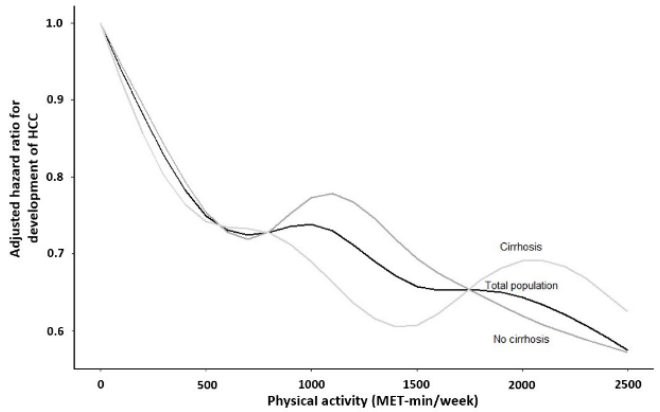
Figure 3. Nonlinear relationship between physical activity and the risk of HCC development according to the presence of liver cirrhosis.